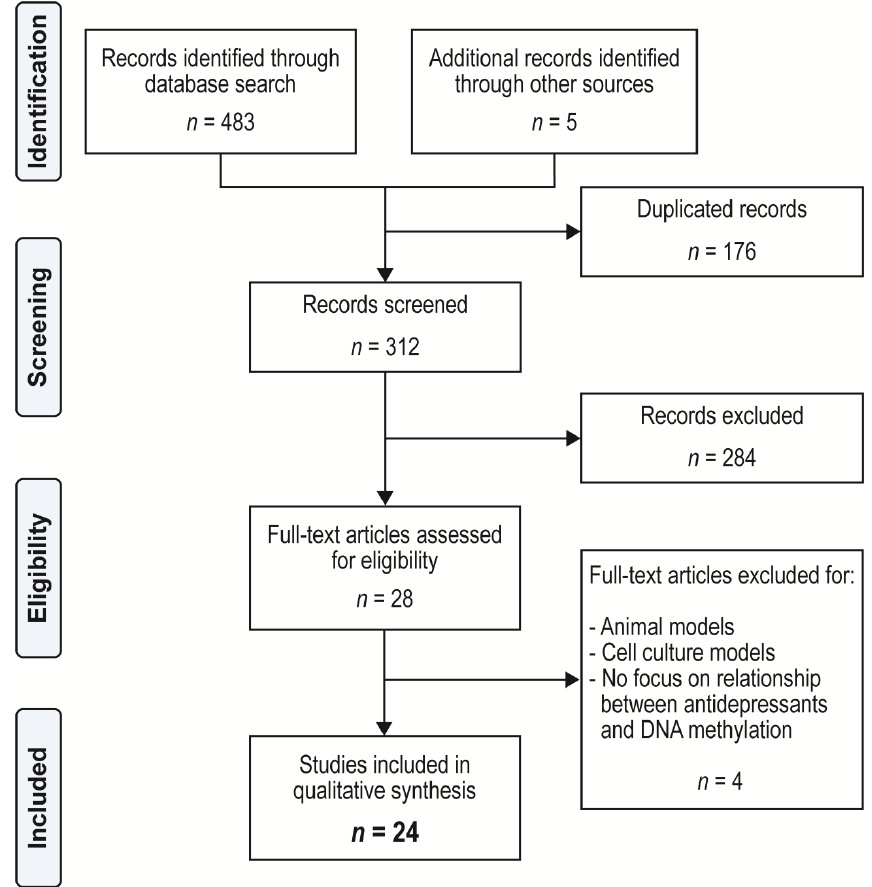
Figure 2. Preferred Reporting Items for Systematic Reviews and Meta-Analyses (PRISMA) flow diagram for systematic literature review [99] . Twenty-four articles met full inclusion criteria. The articles described the relationship between antidepressant administration and DNA methylation in the following genes: Brain-derived neurotrophic factor ( BDNF ) [49 – 55,57 – 59] (Table 1), monoamine oxidase A ( MAOA ) [64,65] (Table 2), 5-hydroxytryptamine (serotonin) transporter ( SLC6A4 ) [67 – 71] (Table 3), norepinephrine transporter ( SLC6A2 ) [72] (Table 3), 5-hydroxytryptamine transporters 1A and 1B ( 5HTR1A/1B ) [77,78] (Table 4), interleukin-6 ( IL6 ) [82], and interleukin-11 ( IL11 ) [85] (Table 5). Two papers reported antidepressant effects on global DNA methylation [86,88] (Table 6).